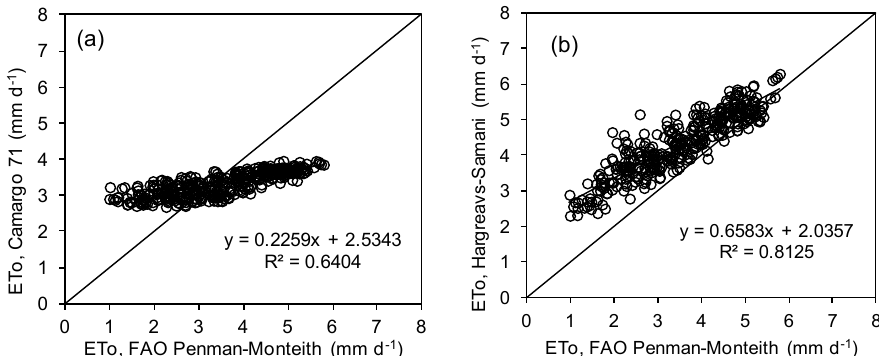
Fig. 8 Relationship between daily ET 0 measured by Penman-Monteith-FAO estimated by the Camargo (a) and Hargreaves-Samani (b) methods.